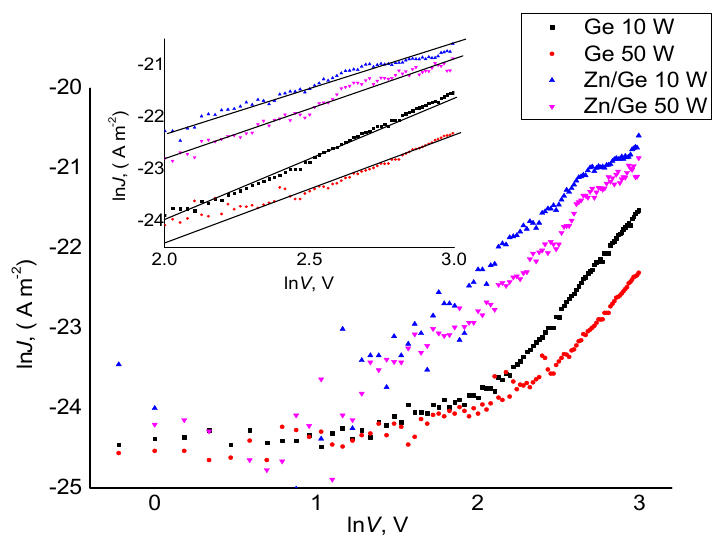
Figure 5. Density ln J with the square root of applied voltage for pristine and composite polymer films manufactured at 10 W and 50 W.